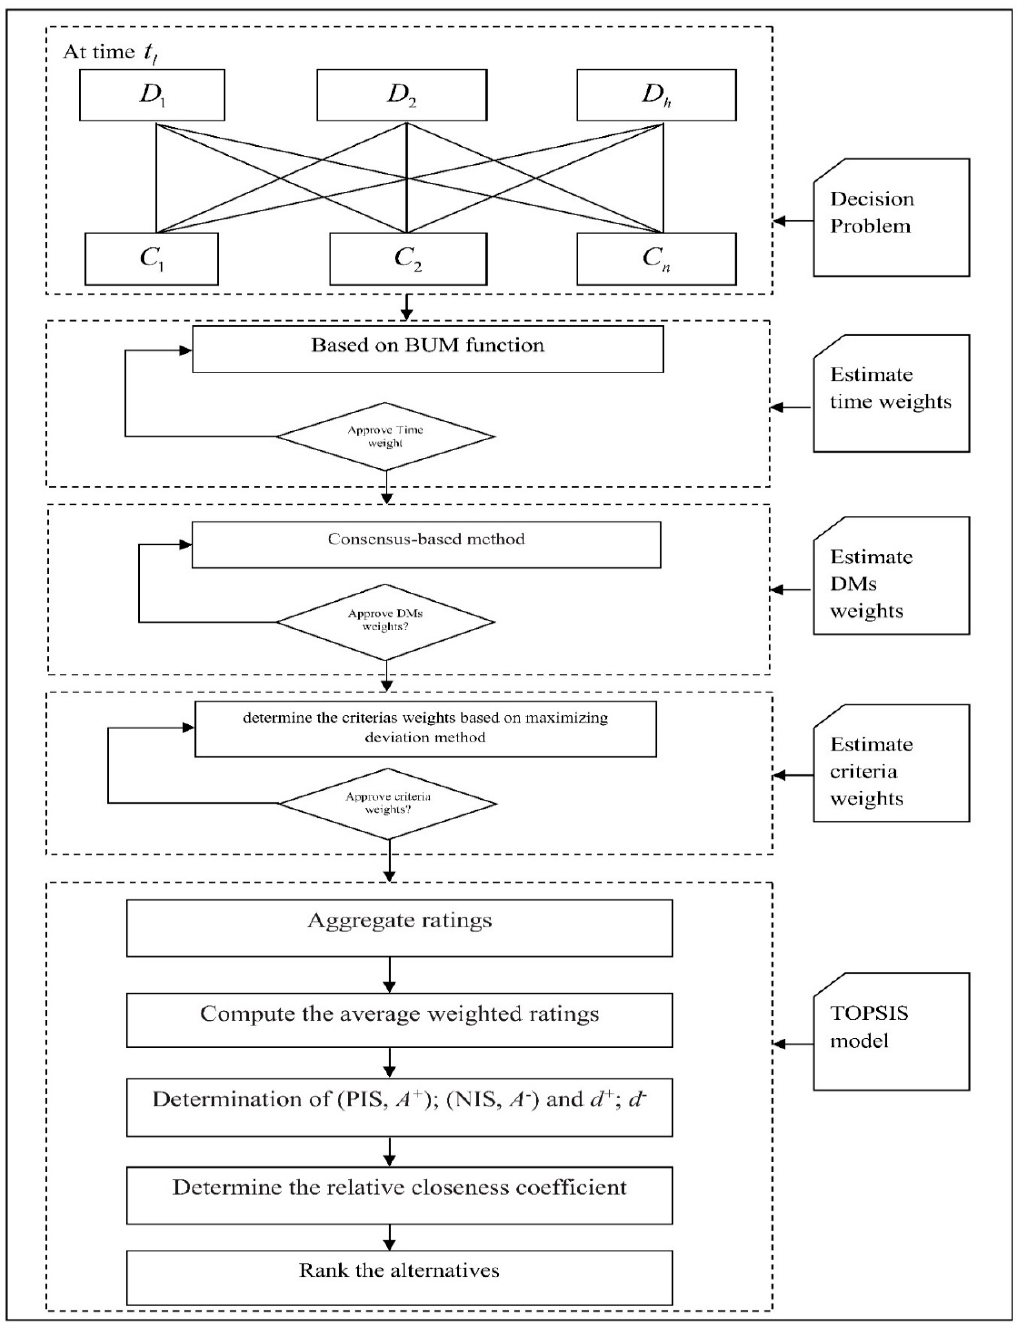
Figure 1. TOPSIS method with unknown weight information.